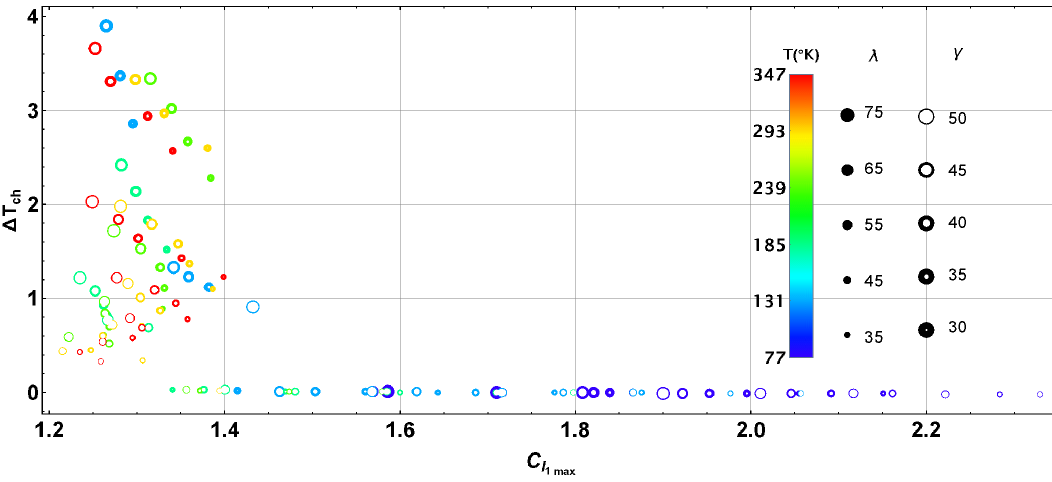
( ρ ) versus ∆ T ch as function of T , λ k and γ k 1